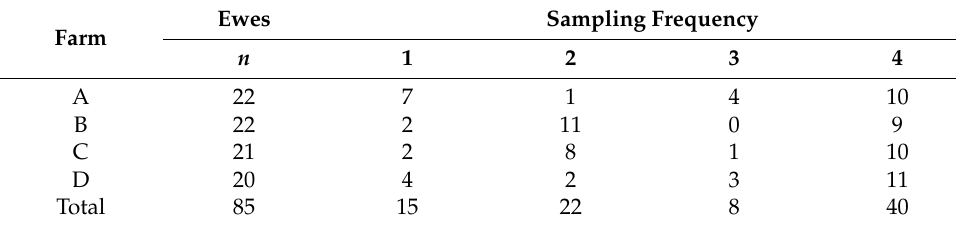
Table 4. Distribution of ewes ( n = 85) by farm and sampling frequency.